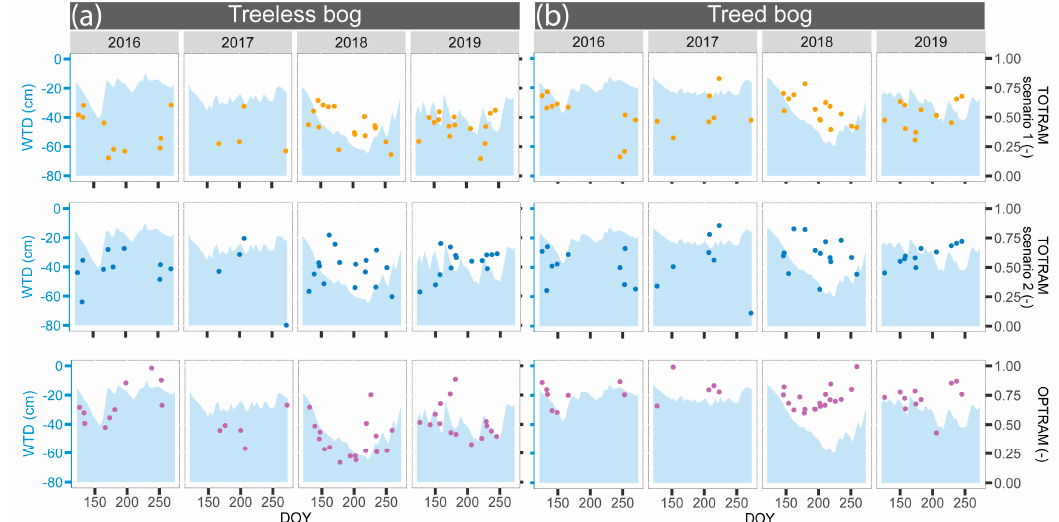
Figure 7. Time series of water table depth (WTD) and soil moisture index from TOTRAM Scenario 1, TOTRAM Scenario 2, and OPTRAM. Time series are exemplarily shown for four years data from monitoring wells 323 ( a ) in a treeless part and 225 ( b ) in a treed part of the bogs.